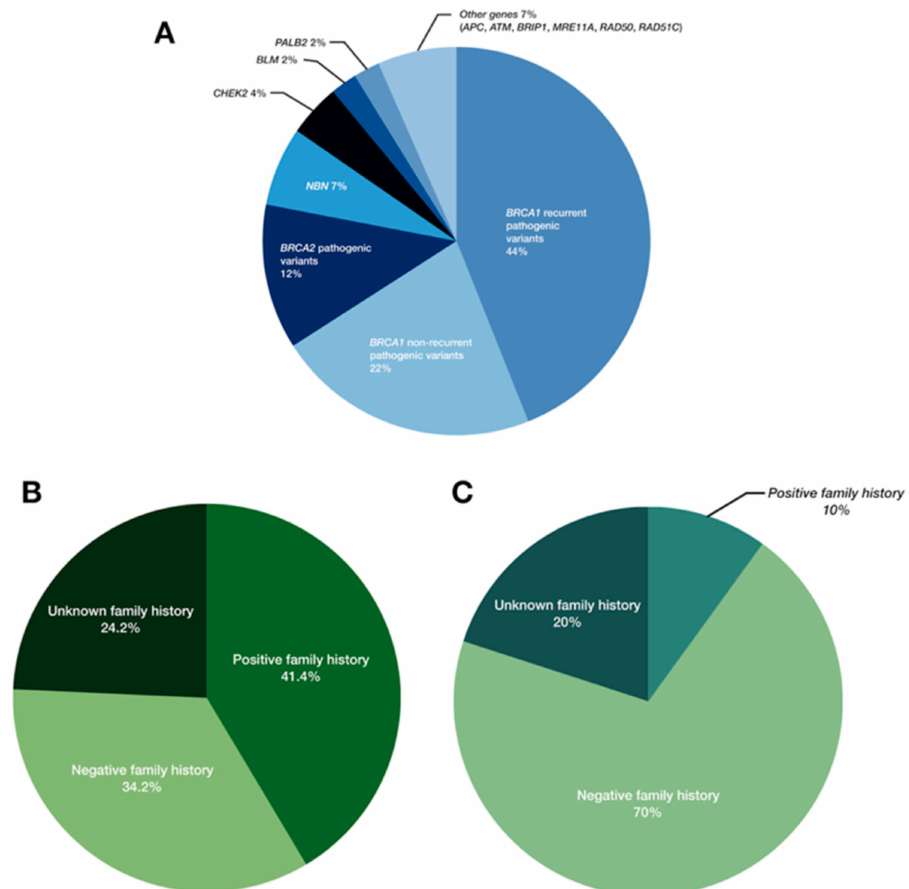
Figure 3. Frequency of pathogenic and likely pathogenic variants in all analyzed genes ( A ), the family history status in the BRCA1 and BRCA2 mutation-positive individuals ( B ) and in the individuals heterozygous for the pathogenic or likely pathogenic variants in other breast/ovarian cancer susceptibility genes ( C